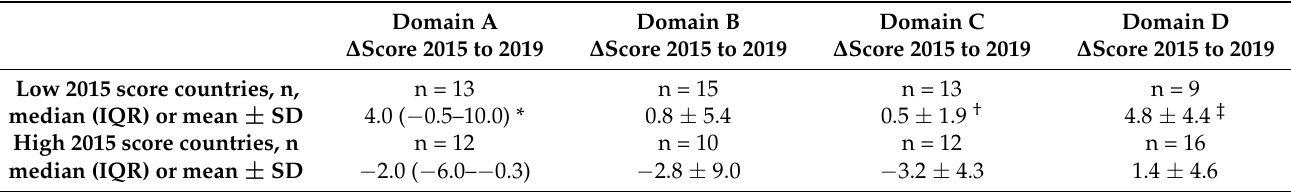
Table 3. Summary results on the tertiary